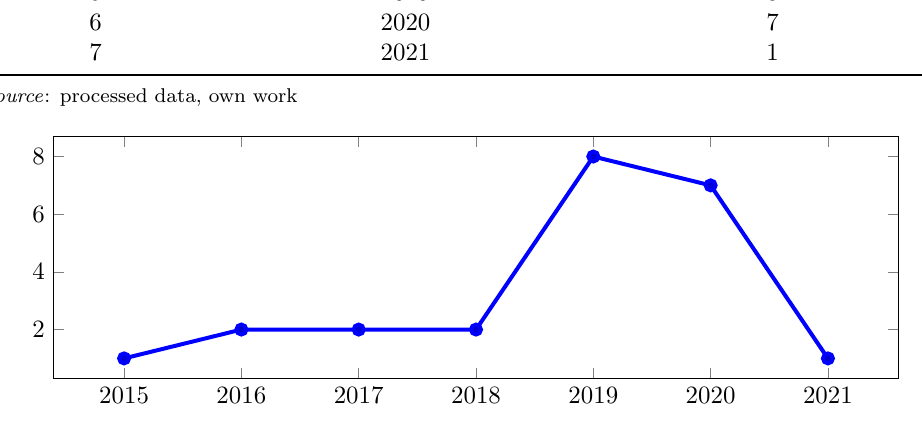
Figure 3: Publication trends over